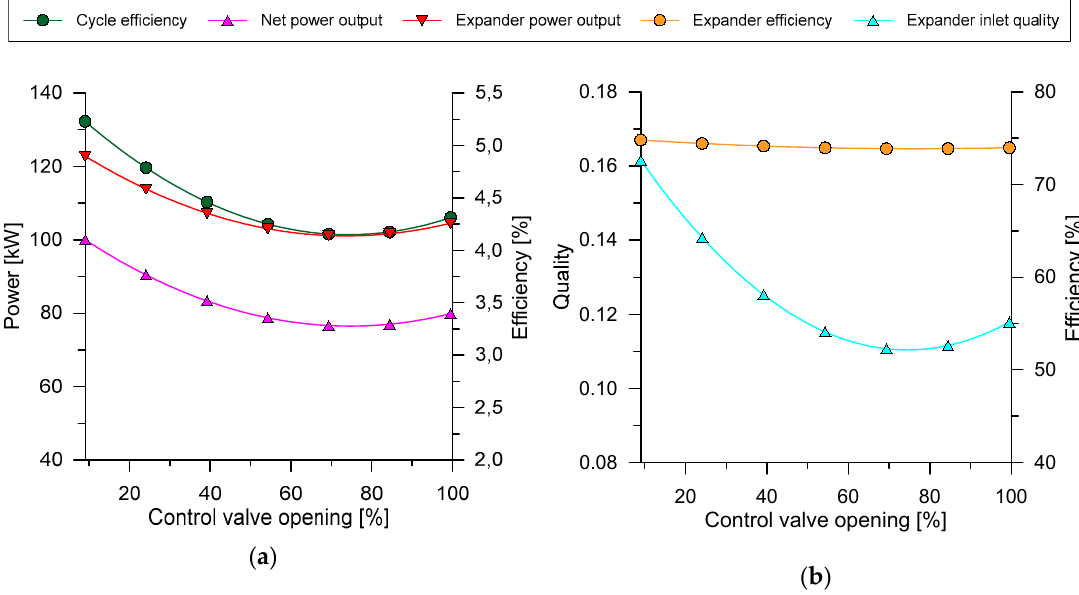
Figure 12. Results obtained by the off-design model simulations varying the control valve opening area: ( a ) Cycle thermal efficiency, net and expander power output; ( b ) expander isentropic efficiency and refrigerant quality at the inlet of the machine.